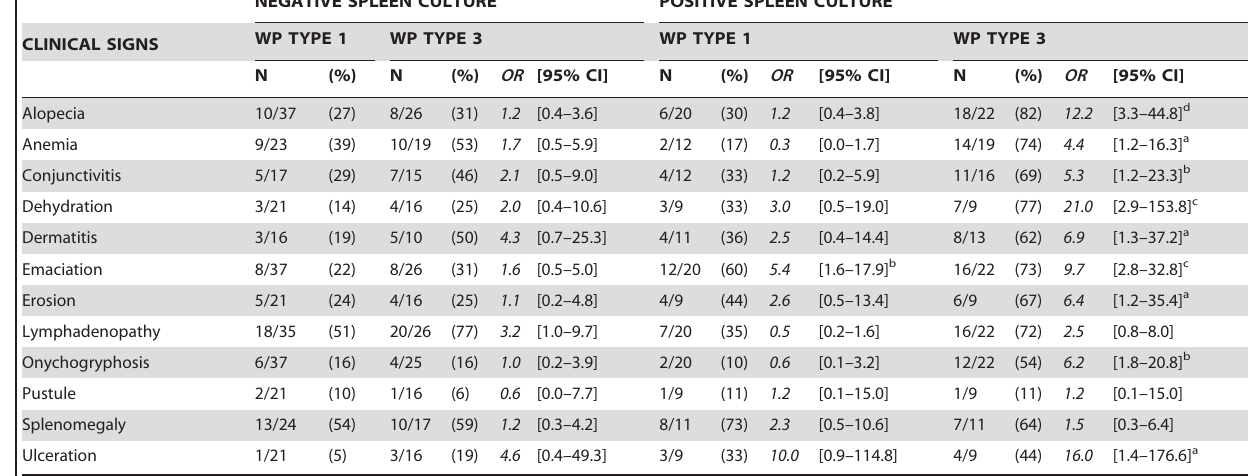
Table 4. Distribution of clinical signs associated with visceral leishmaniasis in dogs with quiescent (negative spleen culture) or active (positive spleen culture) infection by L. infantum and type 1 (normal) or type 3 (moderately to severely disorganized) splenic white pulp